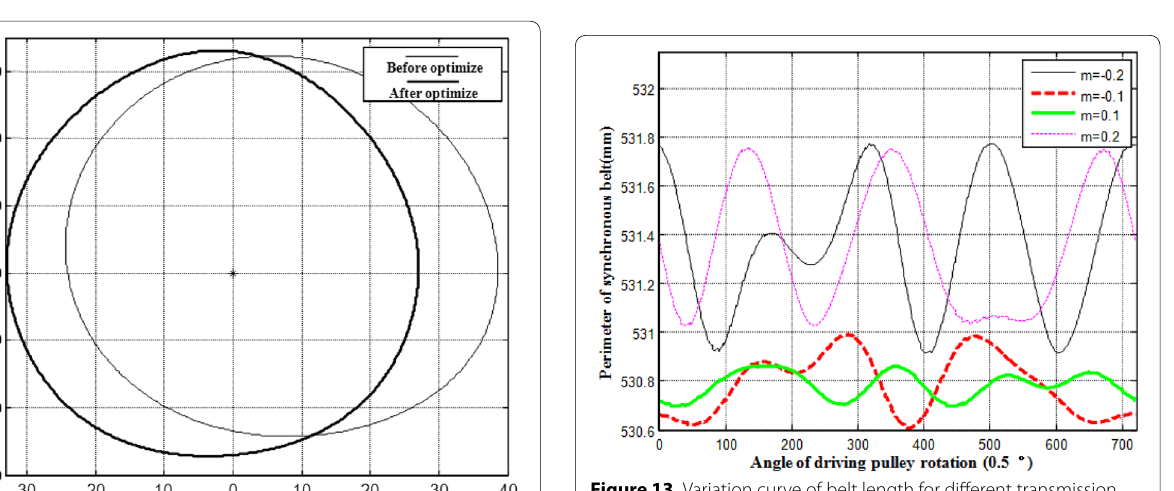
Figure 13 Variation curve of belt length for different transmission